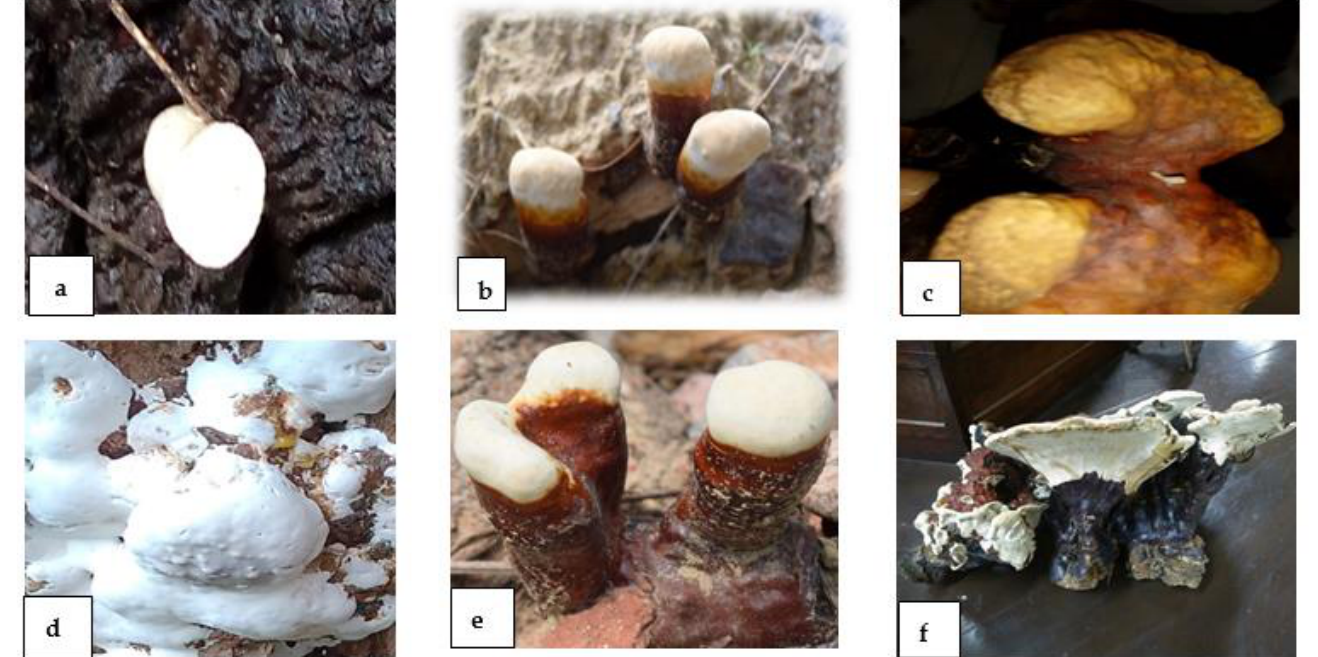
Figure 1. Morphology of different developmental ages, i.e., TW (two-week-old) ( a , d ), FW (four-week-old) ( b , e ) and EW (eight-week-old) ( c , f ) G. lucidum.